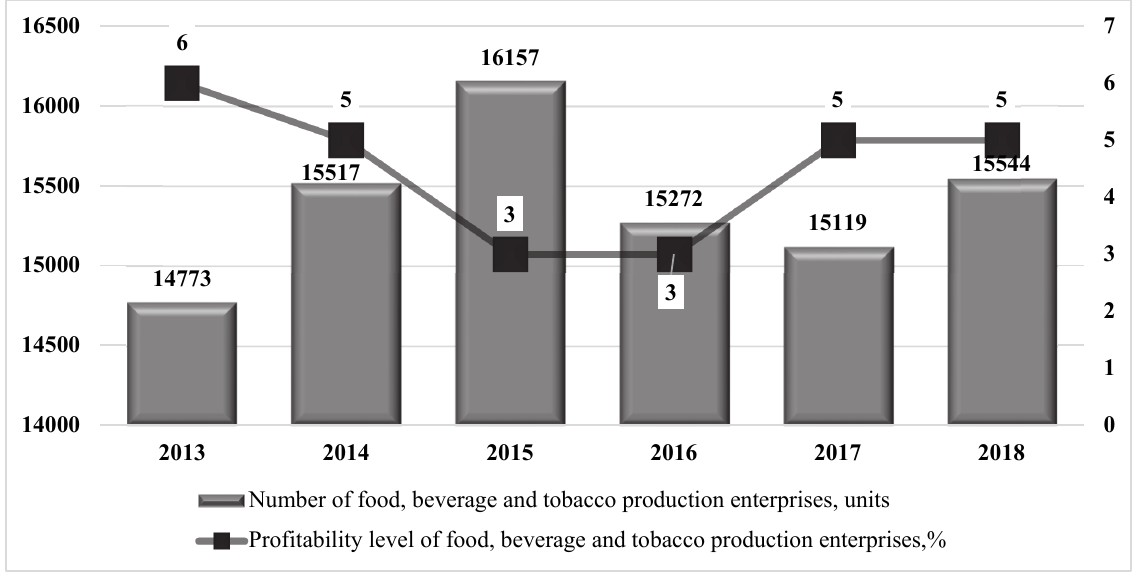
Fig. 2. Business entities dynamics and profitability level of food, beverage and tobacco products in Ukraine Source: calculated by authors based on the data (State Statistical Service of Ukraine, 2019) Analyzing the financial condition of the food industry, it is worth noting that the number of unprofitable enterprises in 2018 decreased by 10.2 percentage points compared to 2010. The profitability level of enterprises operating activities since 2017 indicates the restoration of positive dynamics in the food